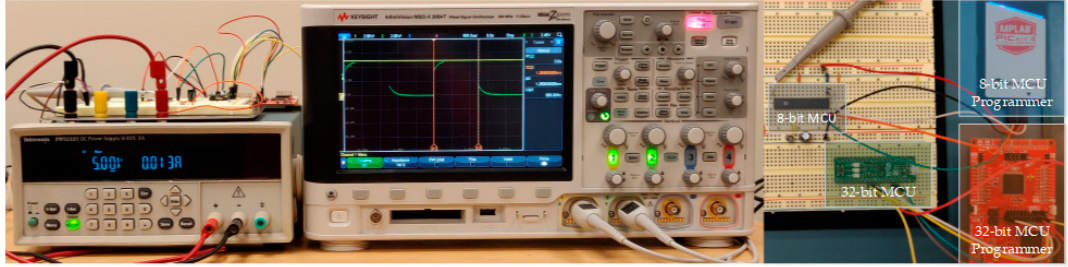
Figure 5. Block diagram of the testbed.